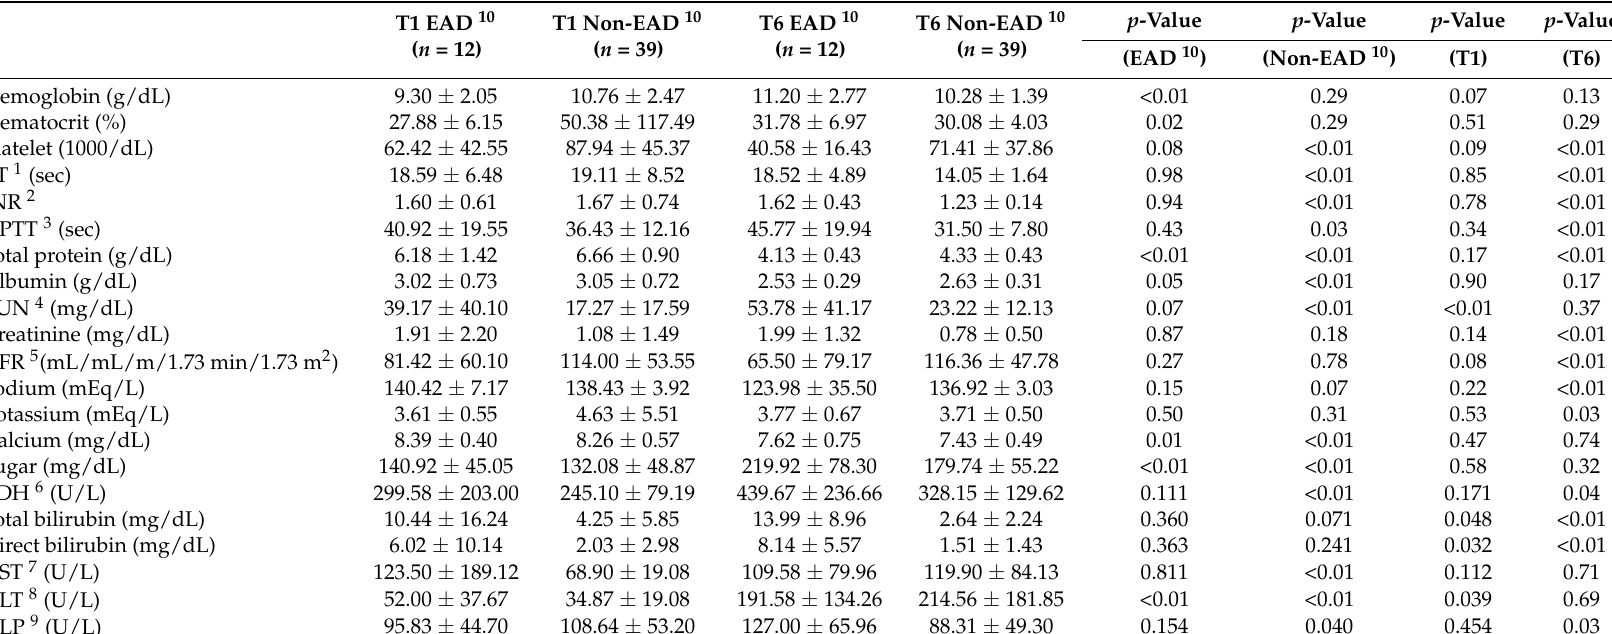
Table 2. Biochemical data for the patients before and after liver transplantation. The p -value denoted as EAD was used to compare EAD patients between T1 and T6, whereas the p -value denoted as denoted as non-EAD was used to compare non-EAD patients between T1 and T6. The p -value denoted as T1 was used to compare the EAD and non-EAD groups at T1 while the p -value denoted as T6 was used to compare the EAD and non-EAD groups at